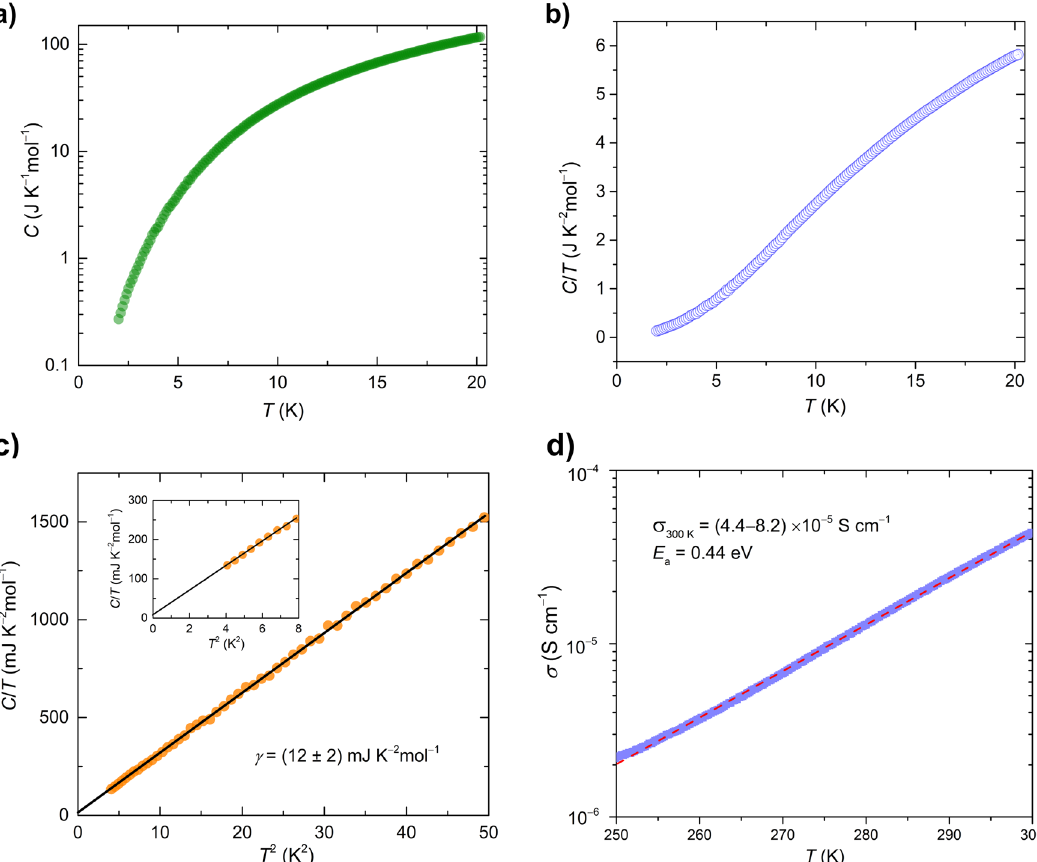
Fig. 5 Heat capacity and temperature dependence of σ of 1. a Temperature dependence of the total heat capacity ( C ) in the T range of 2.0 – 20 K in zero fi elds. b C / T vs T plot. c C / T vs T 2 plot. d The Temperature dependence of σ for single-crystals obtained by using a two-probe method in the range of 250 – 300